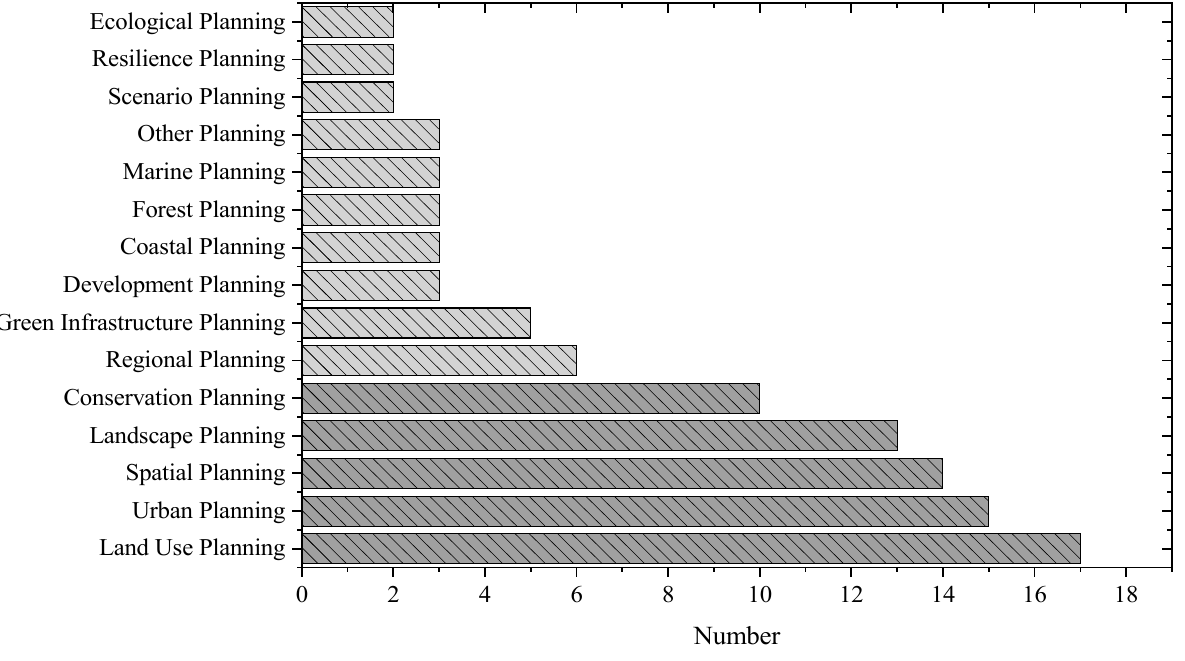
Figure 10. Planning types examined in the selected articles. The x -axis represents the number of different planning types.